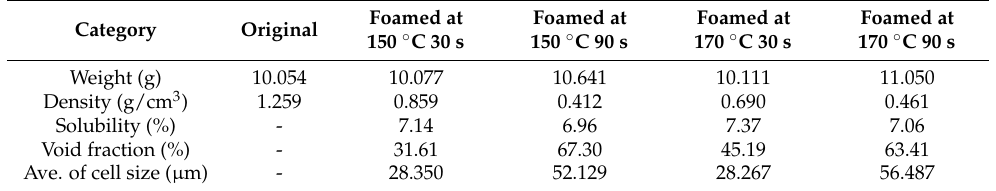
Figure 3. Specimens for low-frequency measurements: ( a ) Non-foamed; ( b ) Original; ( c ) Microcellular foamed at 150 ◦ C and 30 s; ( d ) Microcellular foamed at 150 ◦ C and 90 s; ( e ) Microcellular foamed at 170 ◦ C and 30 s; ( f ) Microcellular foamed at 170 ◦ C and 90 s. Table 3. Specifications of microcellular foamed ceramic urethane for low-frequency